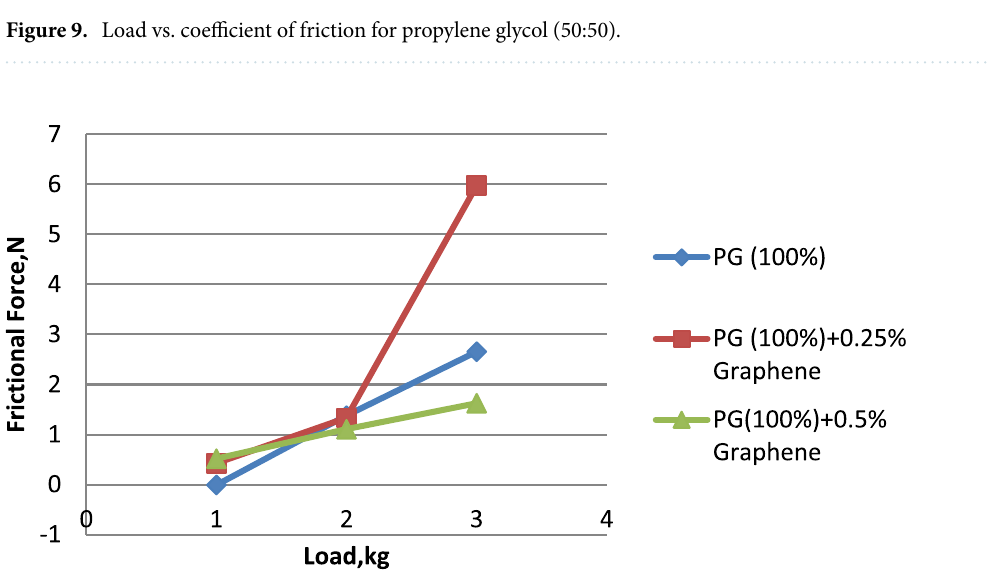
Figure 10. Load vs. frictional force for propylene glycol (100%).